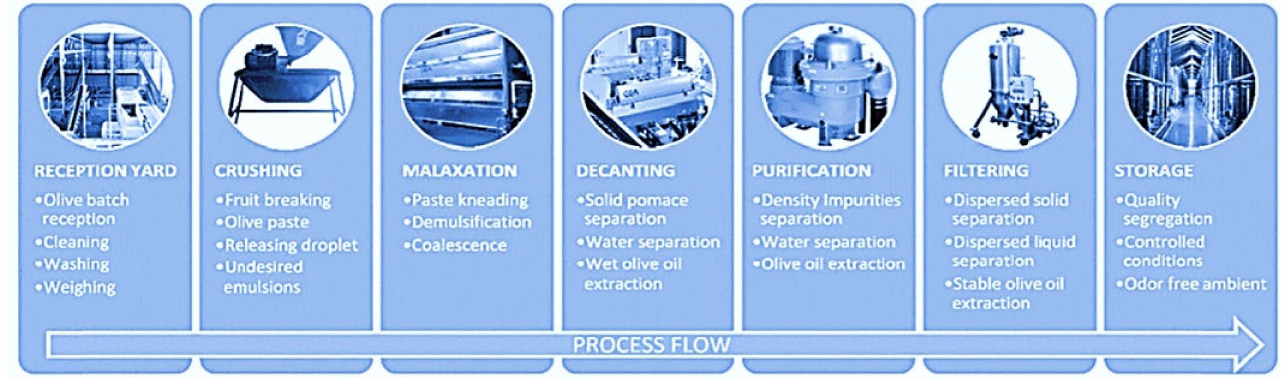
Figure 1. Process scheme for virgin olive oil production. Published from [56] with the permission of the